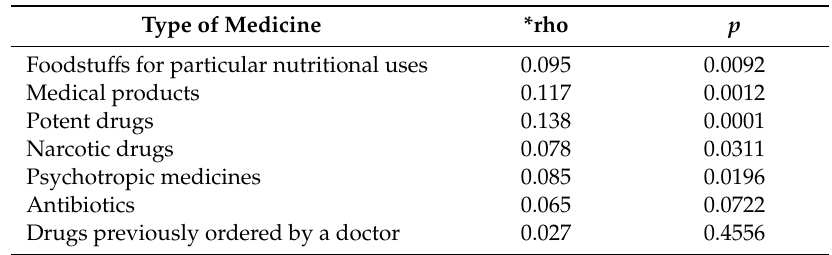
Table 3. Nurses’ self-assessed preparedness for prescribing and their satisfaction with life (as assessed by SWLS).